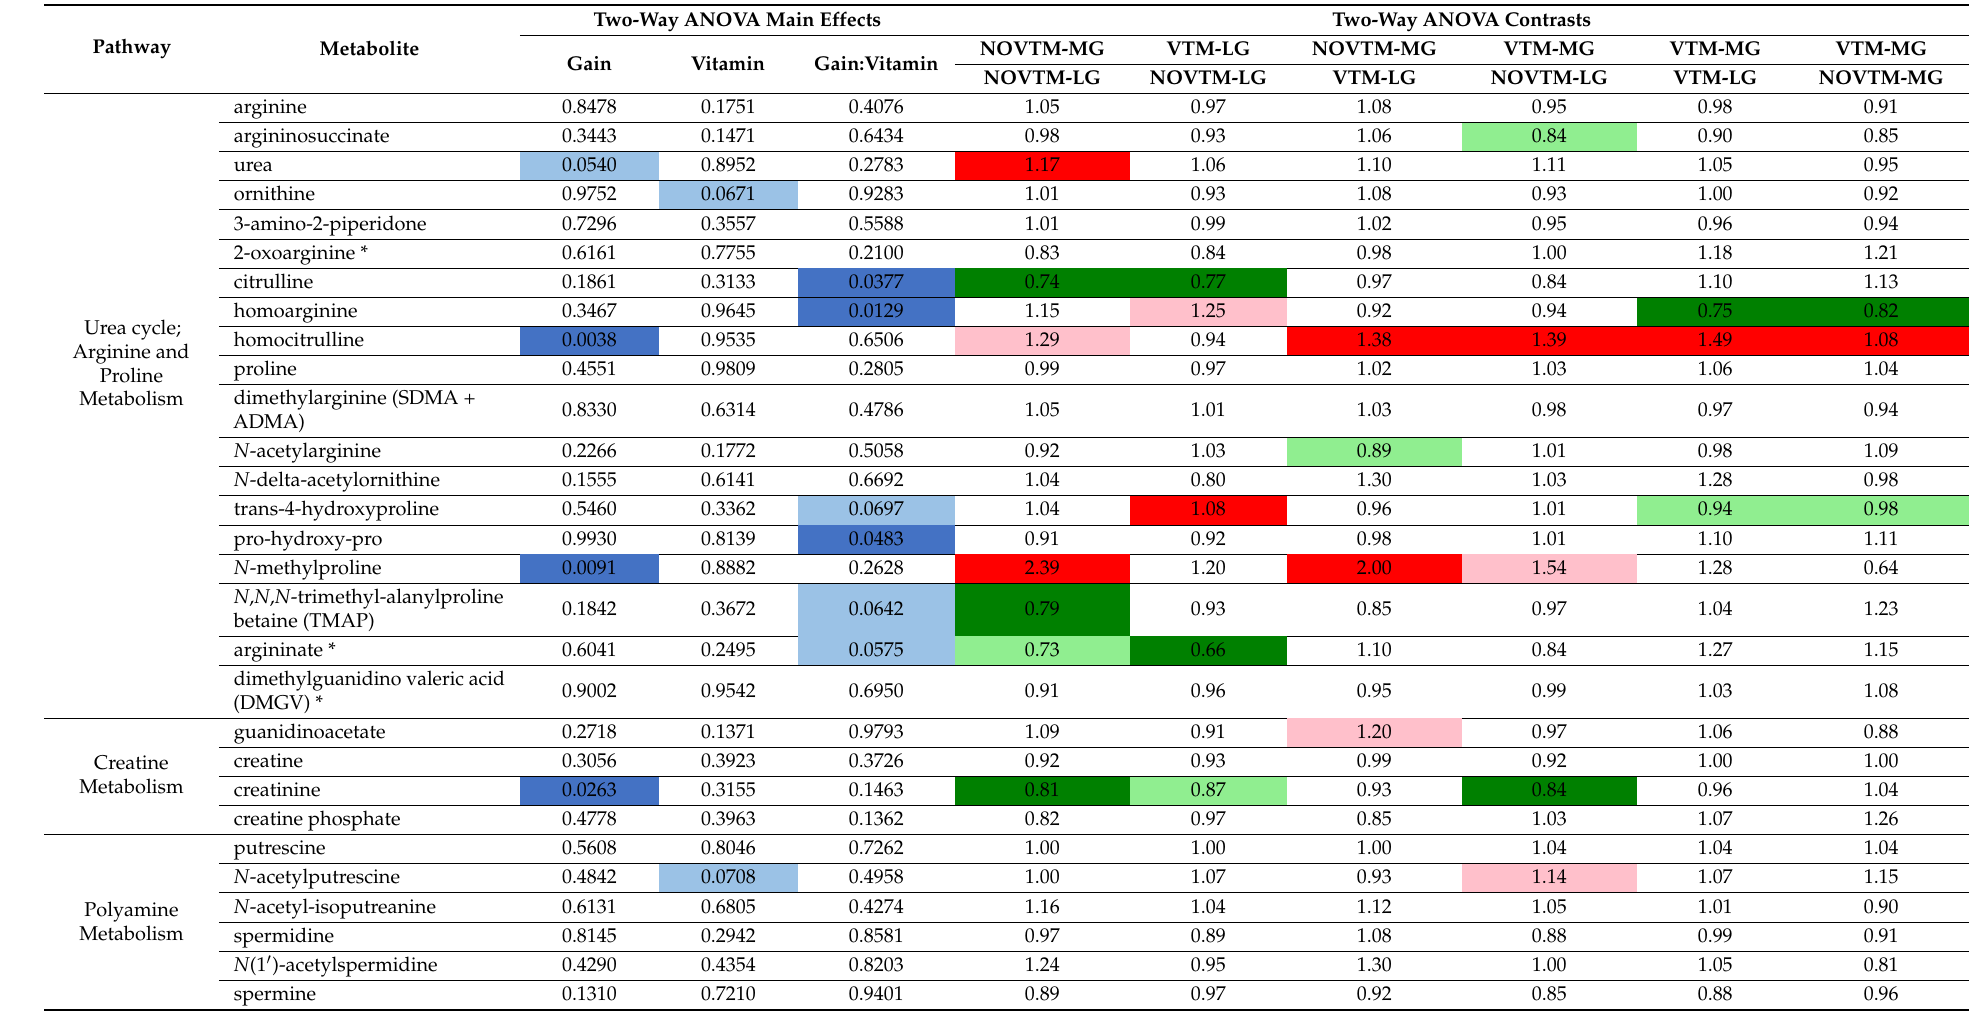
Table 4. Metabolites involved in amino acid metabolism pathways including: (1) Urea cycle, Arginine, and Proline, (2) Creatine, (3) Polyamine, (4) Guanidino and Acetamido, and (5) Glutathione